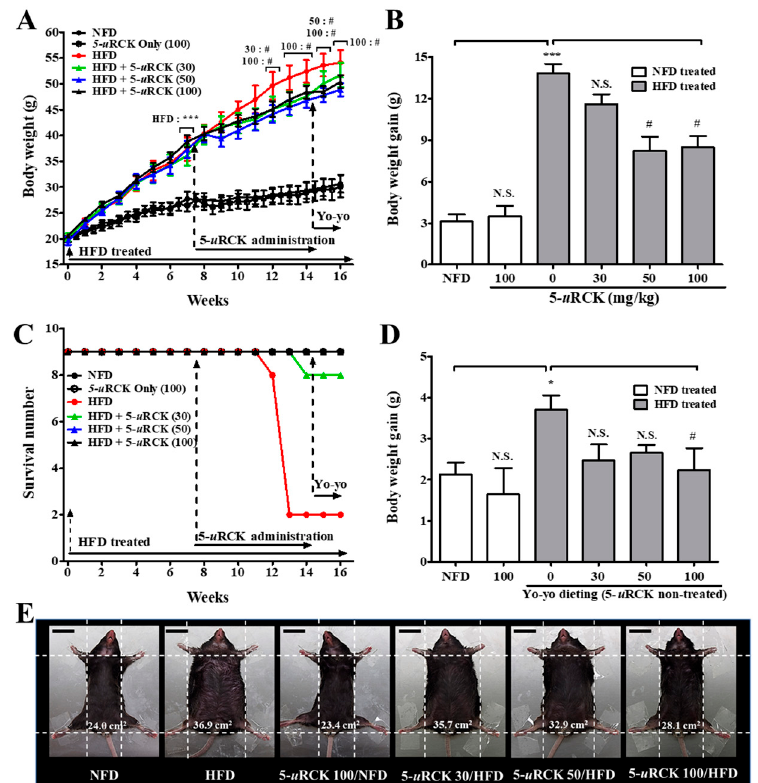
Figure 3. Changes in body weight throughout the experimental period. ( A ) Body weight was monitored three times per week for 16 weeks. ( B ) Body weight gain was measured from the 8th week until the 14th week. ( C ) Effect of 5- u RCK treatment after obesity development on the survival rate. ( D ) Body weight gain was measured from the 14th week until the 16th week. ( E ) Phenotype of representative mice from each group. The body width of each group of mice was checked before sacrifice. The scale bars indicate 20 mm. The results are presented as the mean ± SD (n = 9). * p < 0.05 and *** p < 0.001 vs. normal-fat diet (NFD) group; # p < 0.05 vs. high-fat diet (HFD) group. N.S., not significant.